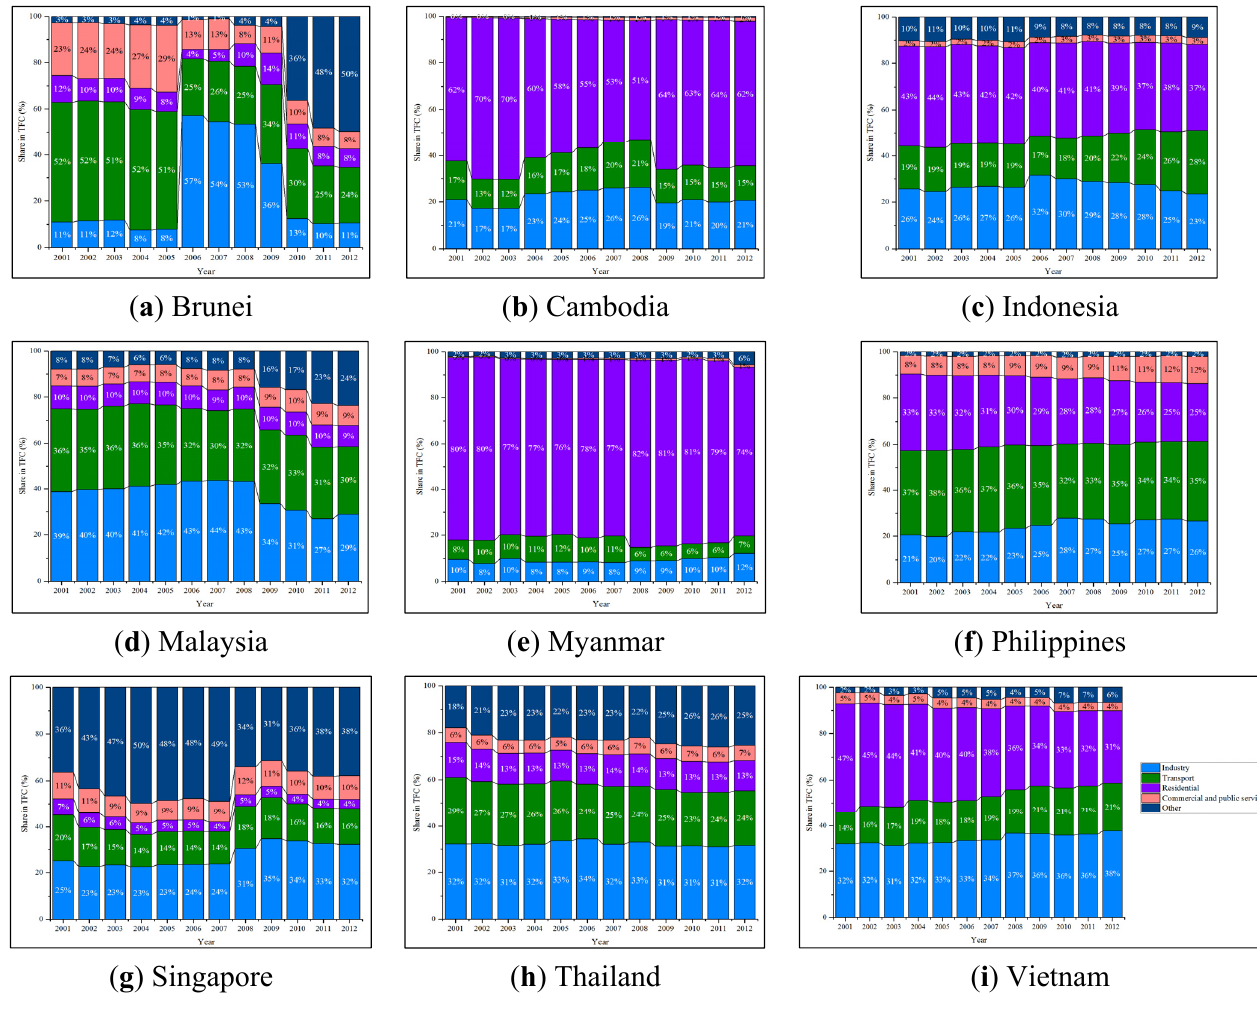
Figure 22. Sectoral energy consumption (by country).